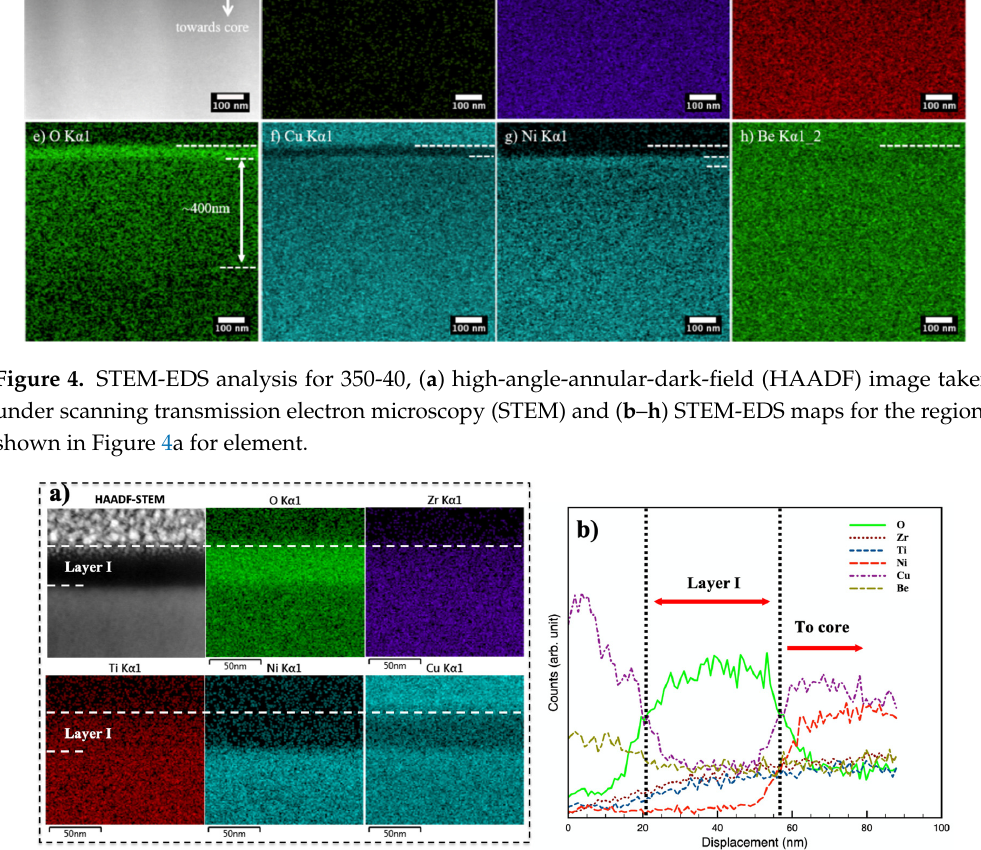
Figure 6. GDOES composition ‐ depth profiles of a ) 350 ‐ 40 and b ) 380 ‐ 4.5; Profiles were plotted based on the optical emission channel of Zr (463 nm), Ti (498 nm), O (130 nm), Ni (225 nm) and Cu (515 nm). An oxygen diffusion layer is clearly revealed on both 350 ‐ 40 and 380 ‐ 4.5 (Figure 6). Composition ‐ depth profiles show similar trend for both treated surfaces. In general, the GDOES results agree well to the STEM ‐ EDS results (Figures 4 and 5). Three characteristic zones could be identified in Figure 6 from surface to core: i) a topmost layer I, containing the highest O content, low Cu concentration and almost depleted in Ni content, ii) an intermediate layer II, showing a concentration peak in both Ni and Cu, while the oxygen profile drops rapidly, and iii) an underlying layer III of low oxygen content and a slowly reducing oxygen profile. Layer I corresponds to the topmost layer observed under TEM (Figures 2 and 3) and STEM (Figure 4). Owing to the small concentration difference in Cu and Ni